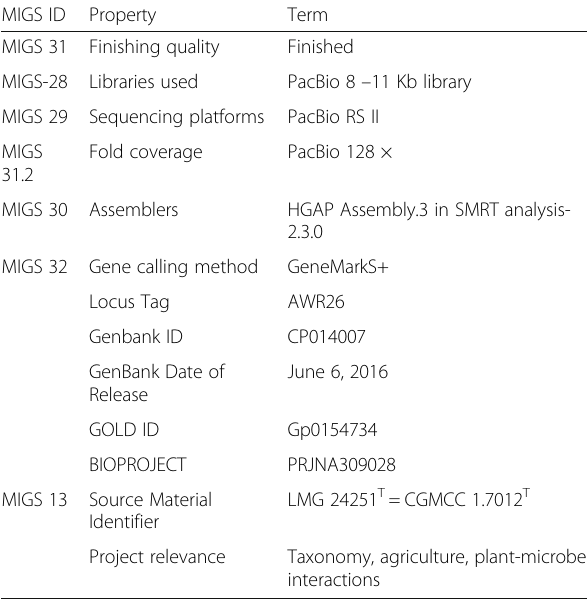
Table 2 Genome sequencing project information for Kosakonia oryzae strain Ola 51 T